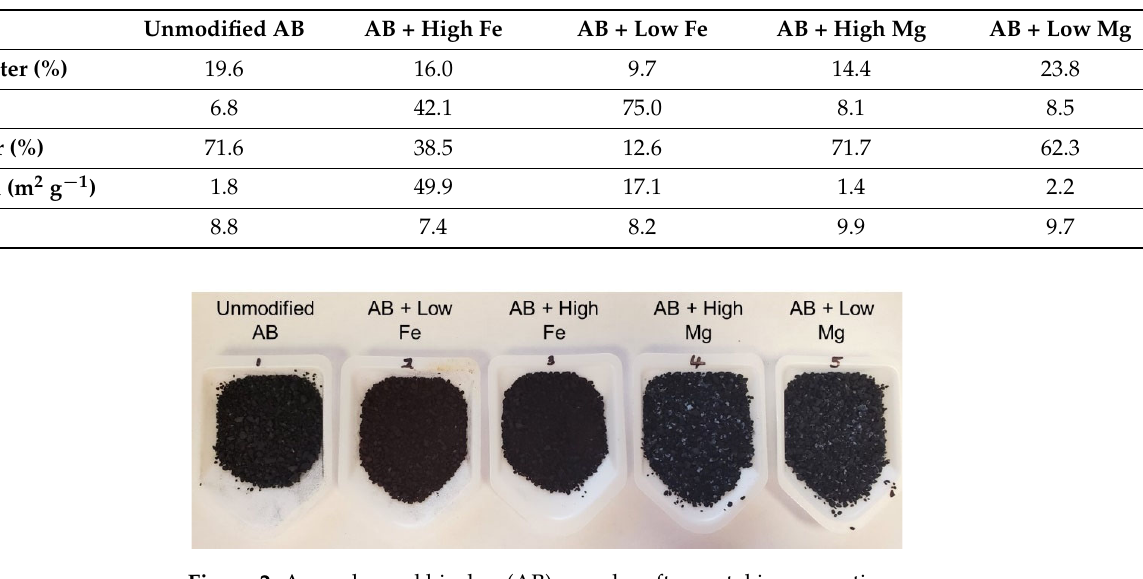
Figure 4. Fourier transform infrared (FTIR) spectra of avocado seed biochar (AB). 3.2. Intial pH Effect on Phosphate Adsorption Unmodified AB equilibrated with 10 mg PO 43 ‐ L − 1 showed no phosphate adsorption and released phosphate from the biochar itself, as noted in other studies of plant ‐ or wood ‐ based biochar (Figure 5) [7,48]. Thus, unmodified AB was not included for the phosphate adsorption isotherm. The greatest release of phosphate (25%) was found in the lowest pH